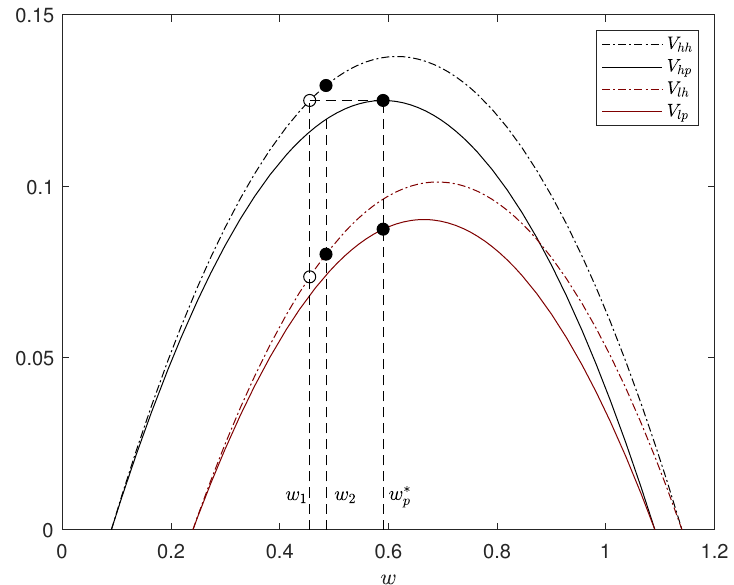
Figure A1. Demonstration of the refinement over pooling equilibria by the intuitive criterion. The parameters are: t = 1, p c = 0.3, µ = 0.5, G = 0, a = 1, b = 0.2, e h = 0.7 and e l =